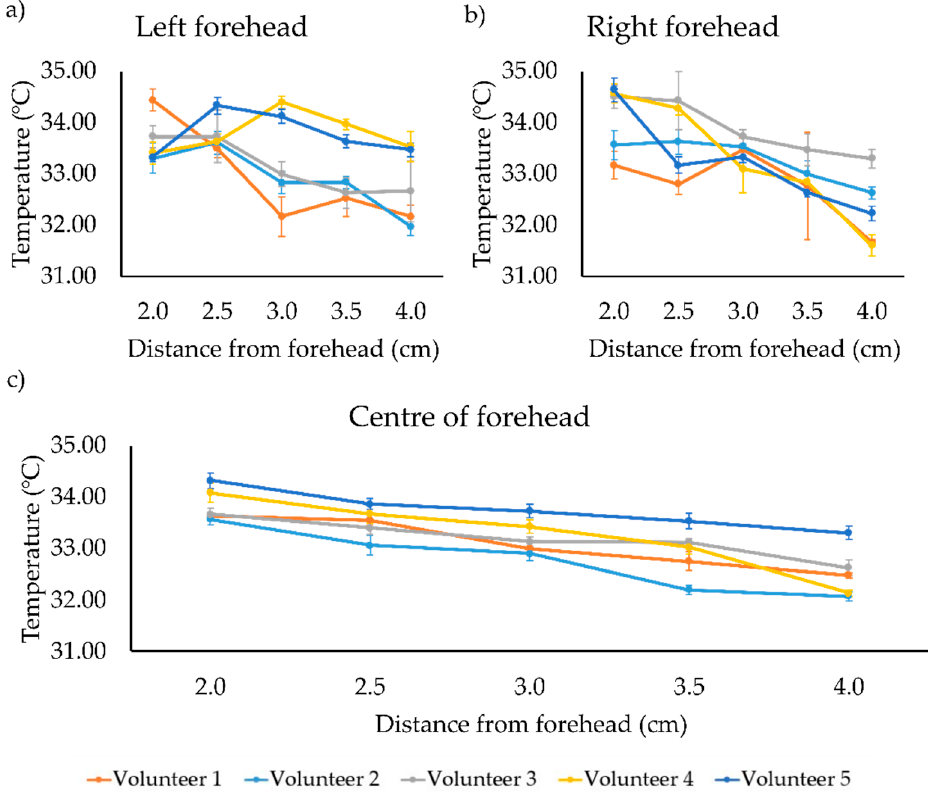
Figure 4. Measured forehead temperatures against the distance between 2–4 cm for each volunteer taken on the ( a ) left of the forehead, ( b ) right of the forehead, and ( c ) center of the forehead prior to the compensation adjustments. Error bars represent the standard deviation from triplicate experiments. Table 1. Variations in the forehead temperature measured from the center and lateral positions of the forehead of five volunteers using our IR thermometer prior to the compensation adjustments.